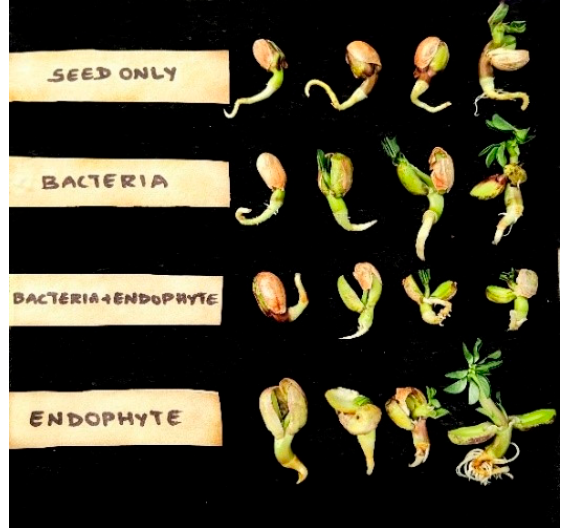
Figure 1. Results from in vitro germination and growth tests. Treatments include seed only as control, treatment inoculated with nitrogen fixing Bradyrhizobium bacteria, treatment co-inoculated with Bradyrhizobium and Trichoderma , and treatment inoculated with plant growth promoting endophytic fungi Trichoderma .